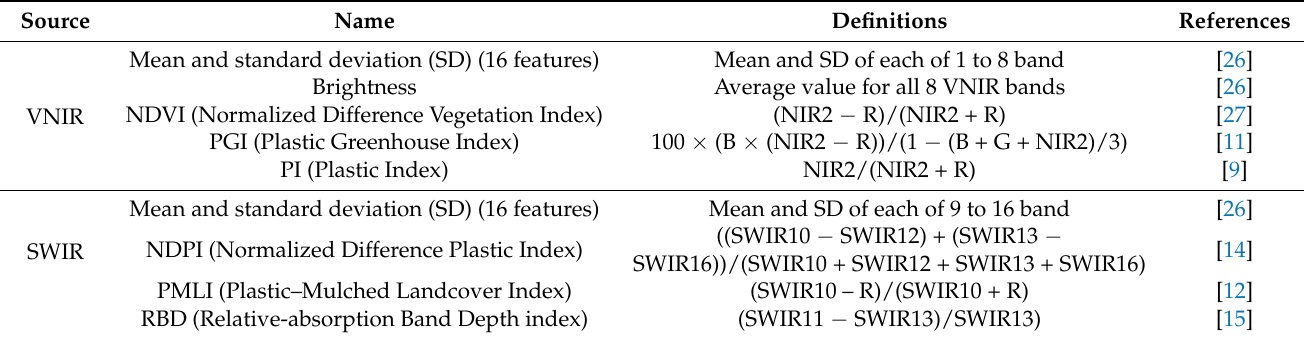
Table 2. WorldView-3 VNIR and SWIR object-based features. The WV3 band names (as given in Table 1) represent the related ground reflectance